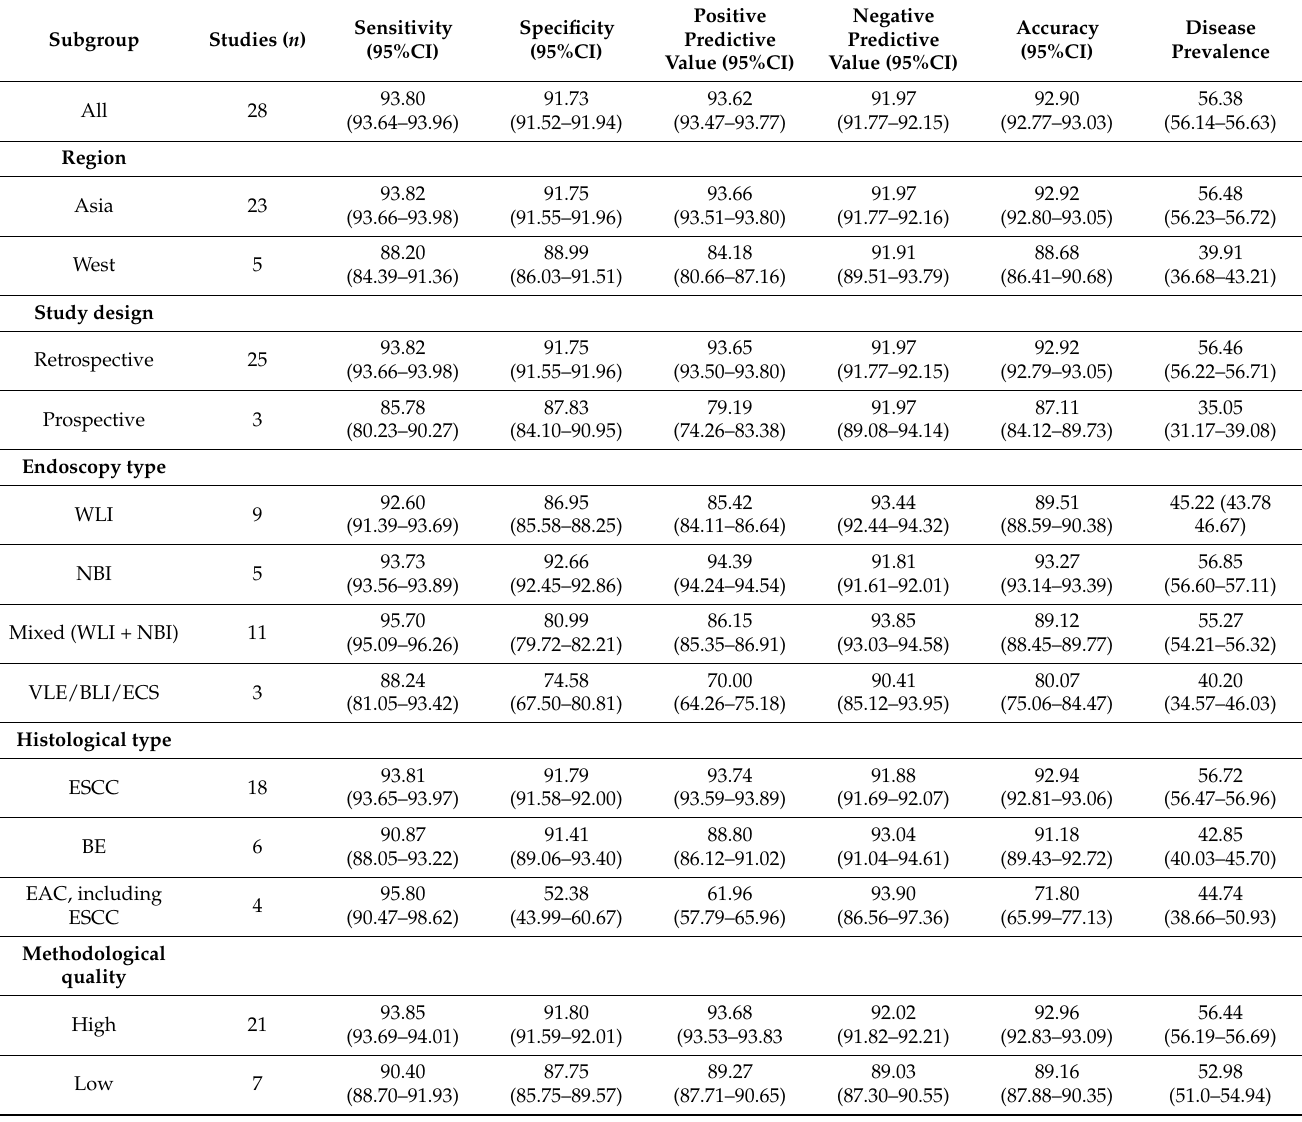
Table 2. Subgroup analyses for the diagnosis of esophageal